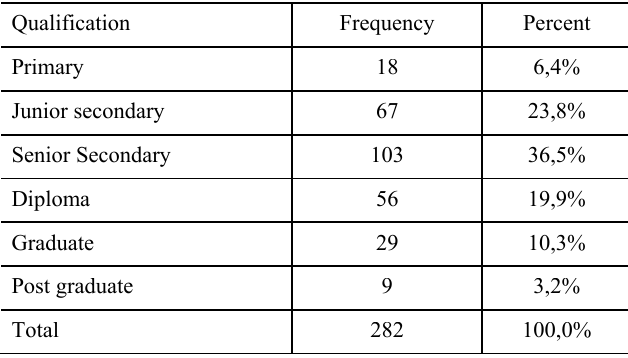
Table 3: Level of qualification of the